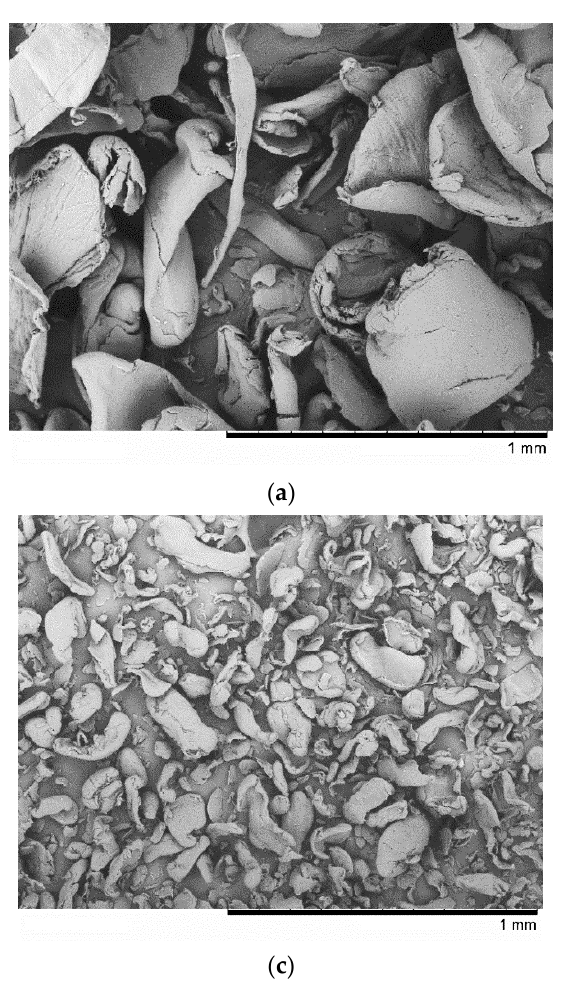
Figure 2. The SEM morphology of chitosan: ( a ) high MW, ( b ) medium MW, and ( c ) low MW.